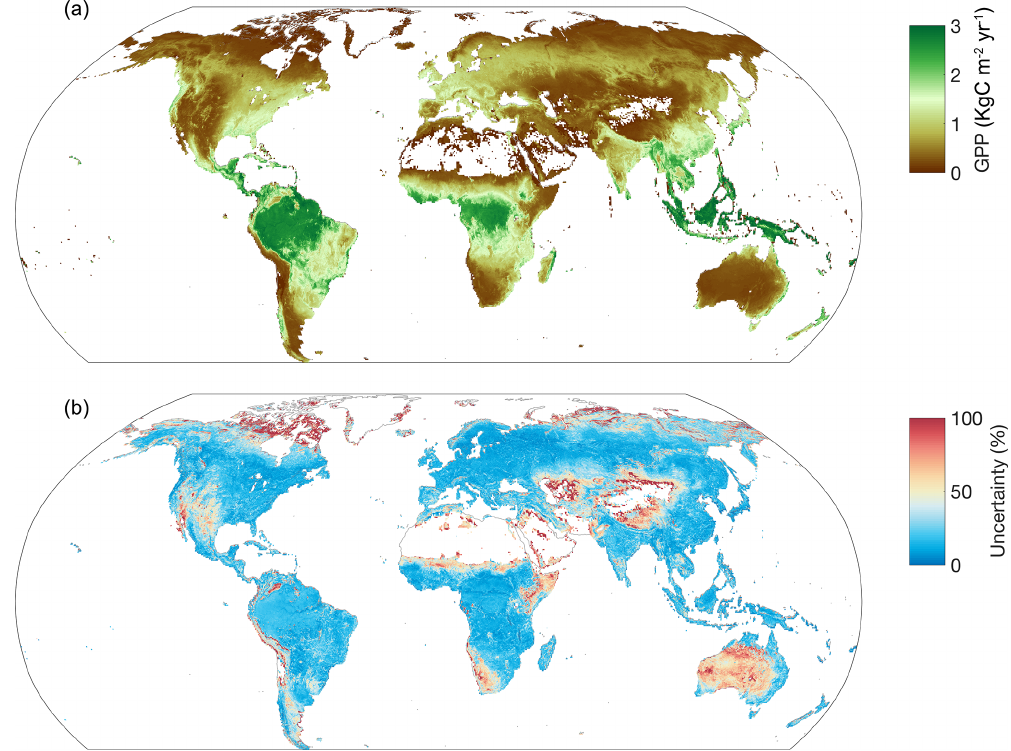
Figure 4. Spatial distributions of GPP and its uncertainty. Panel (a) shows the spatial distribution of mean annual GPP, and panel (b) shows the relative uncertainties (calculated as a ratio of interquartile range to mean). The ranges of both the color bars approximately span between the 1st and the 99th percentiles of the